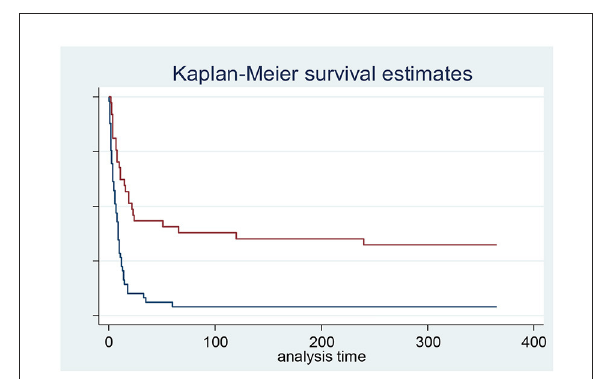
FIGURE2 Ischemic ventricular septal defect survival according to the realization of surgical repair (red curve) or not with only medical management (blue curve). Log-rank test p -value < 0.001. On 97 patients. 11 patients were lost of follow-up and not included in survival